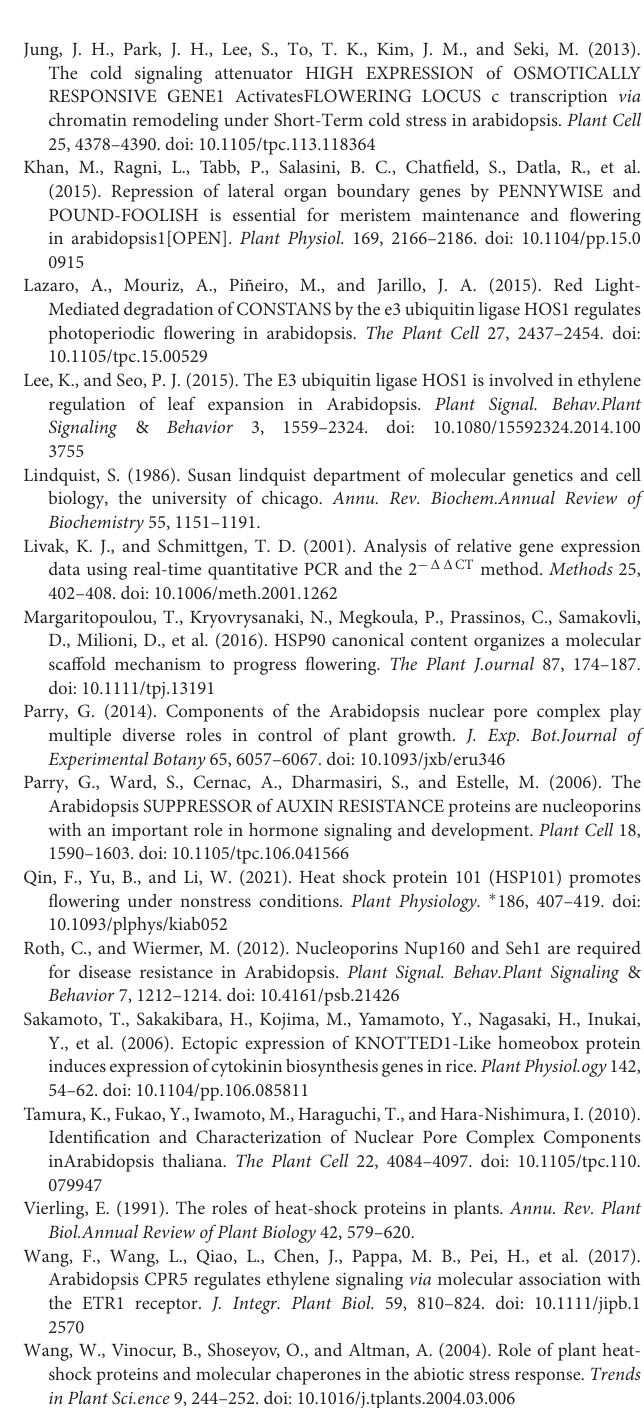
Supplementary Table 1 | Primers used for qRT-PCR. Supplementary Table 2 | Primers used for plasmid